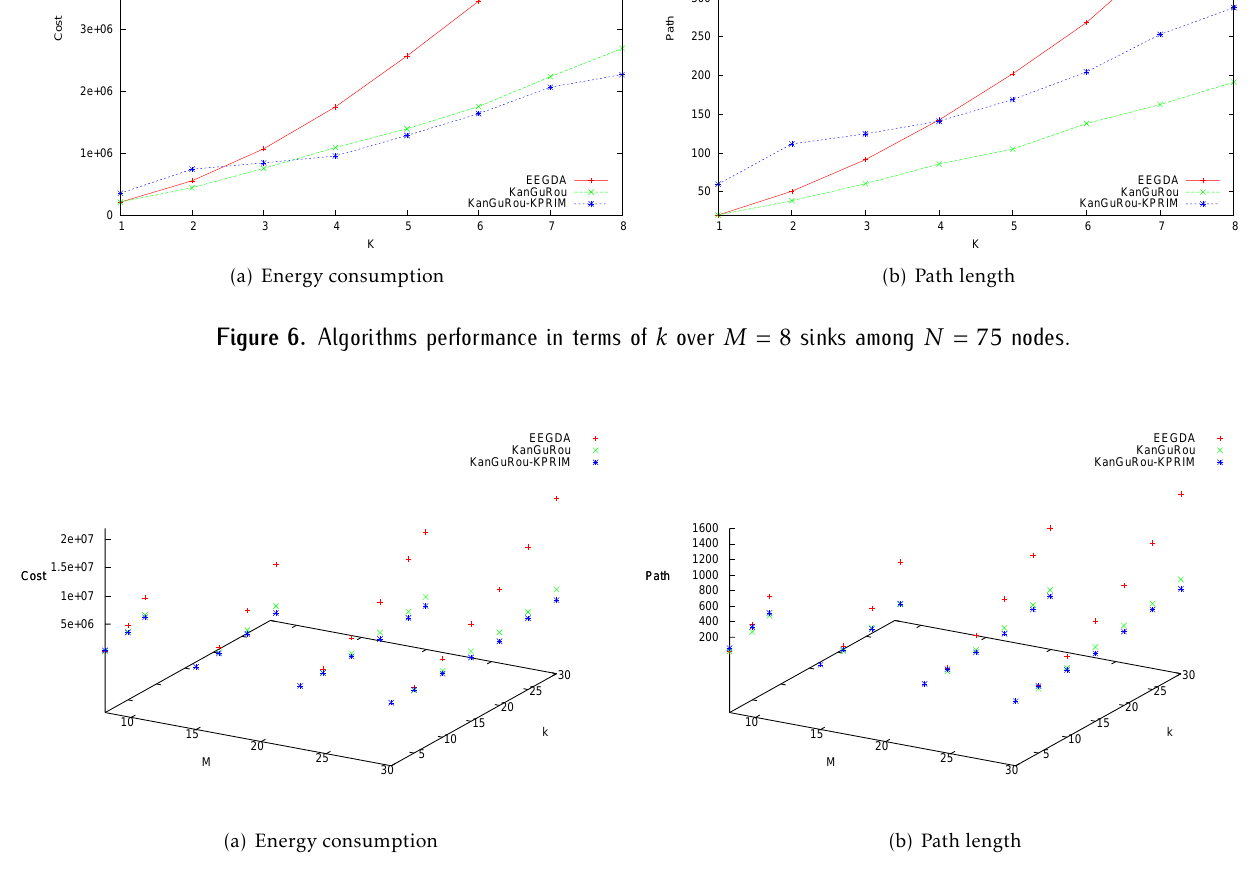
Figure 7. Algorithms performances with regards to M and k for N = 75